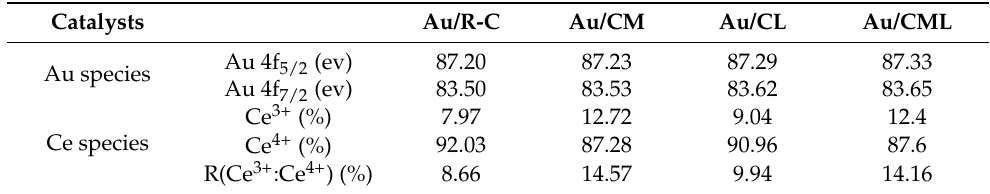
Figure 4. XPS spectra of Au 4f . Table 2. Binding energies of Au and surface Ce species of the catalysts .